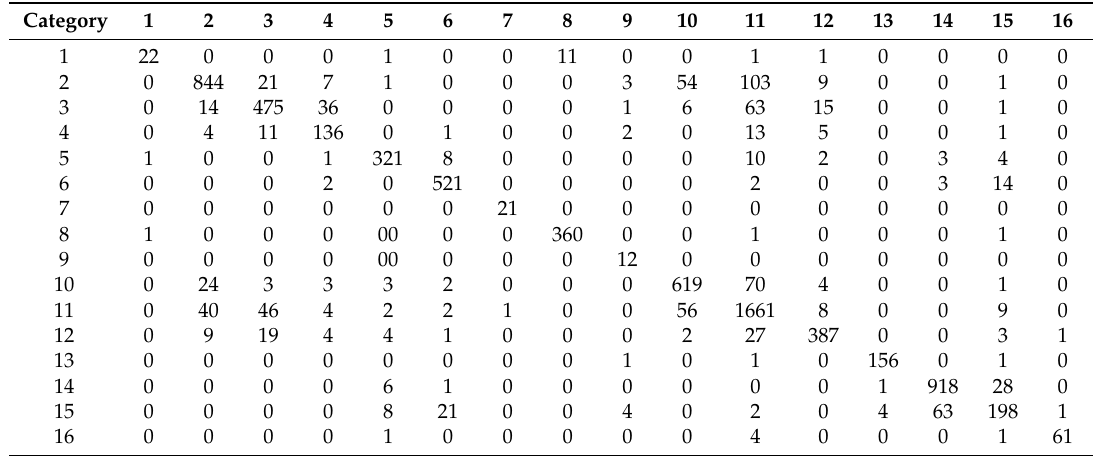
Table 9. Confusion matrix for maximum overlap pooling CNN classification used Indian Pines dataset.